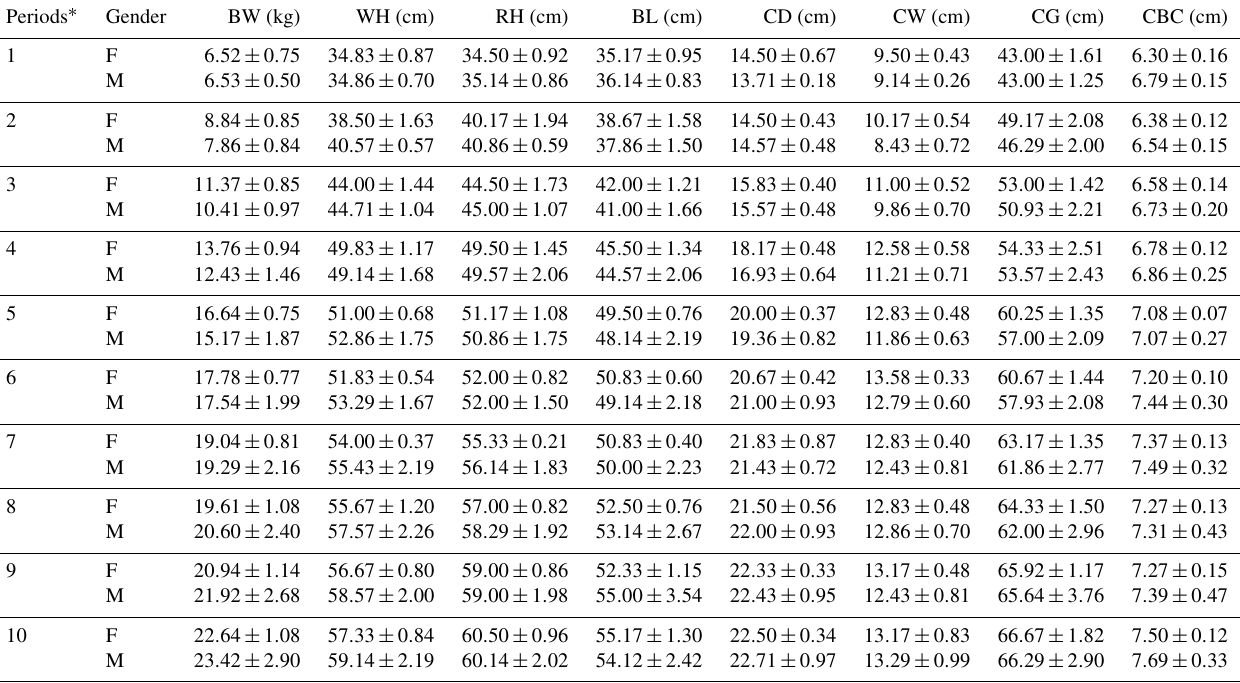
Table 4. Periodic mean values ( X ± Sx ) of some body trait measures in White goat